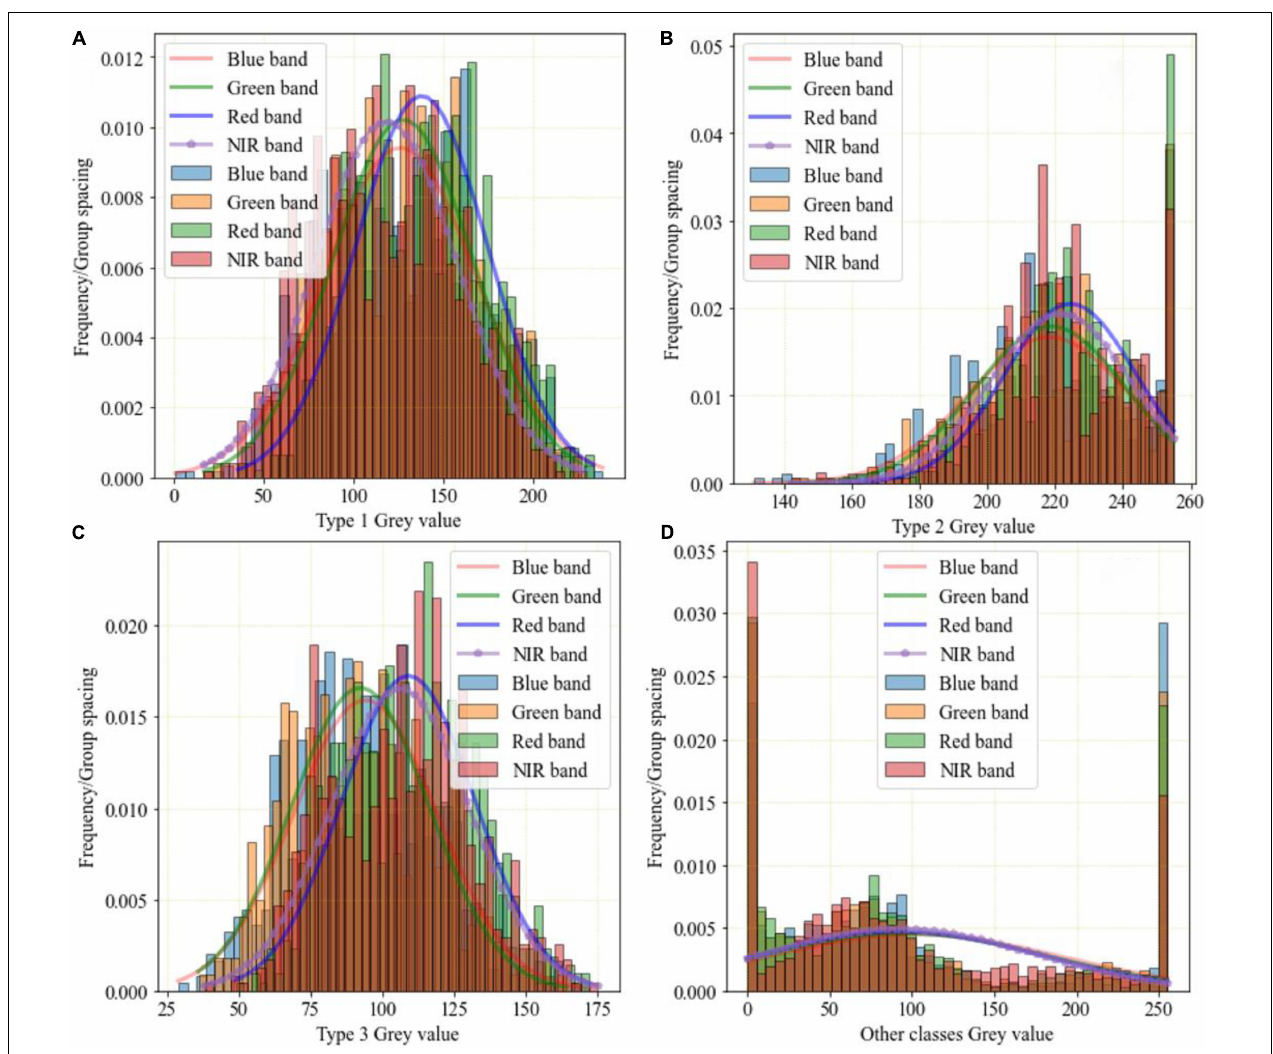
FIGURE 3 | Frequency distribution of sample points of GF-2 multispectral image. (A) Type 1 gray value. (B) Type 2 gray value. (C) Type 3 gray value. (D) Other classes gray